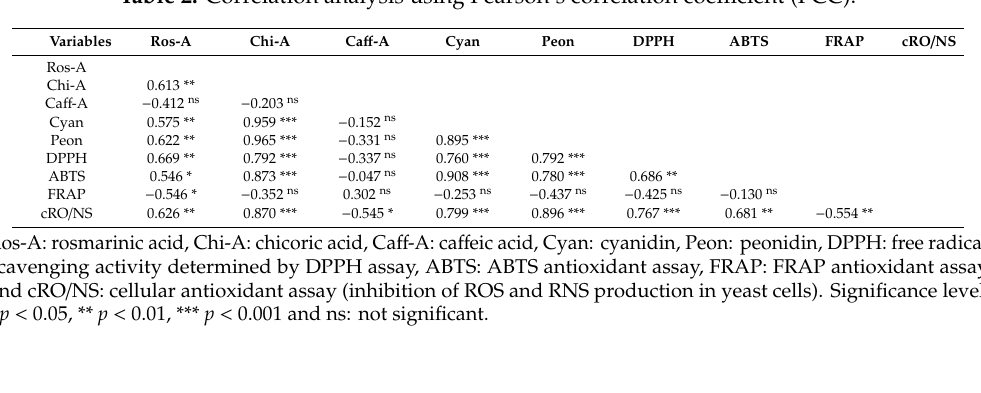
Table 2. Correlation analysis using Pearson’s correlation coe ffi cient